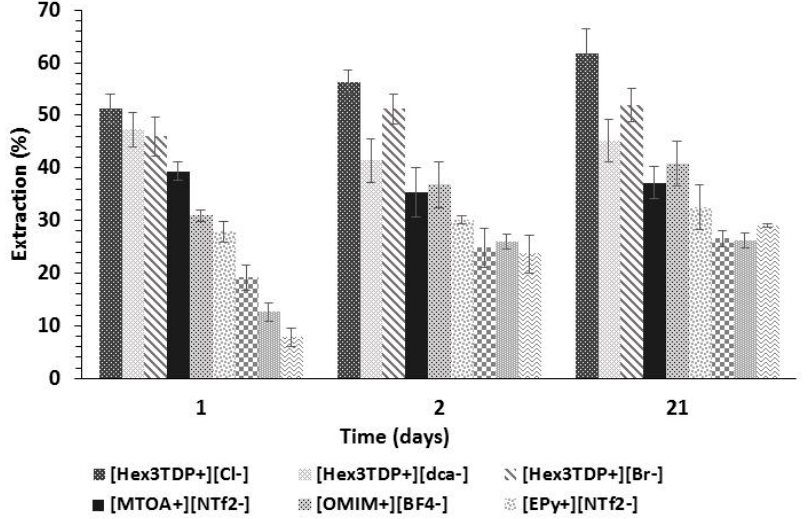
Figure 7. Percentage of ethanol extracted over time by using the water-immiscible ionic liquids selected.